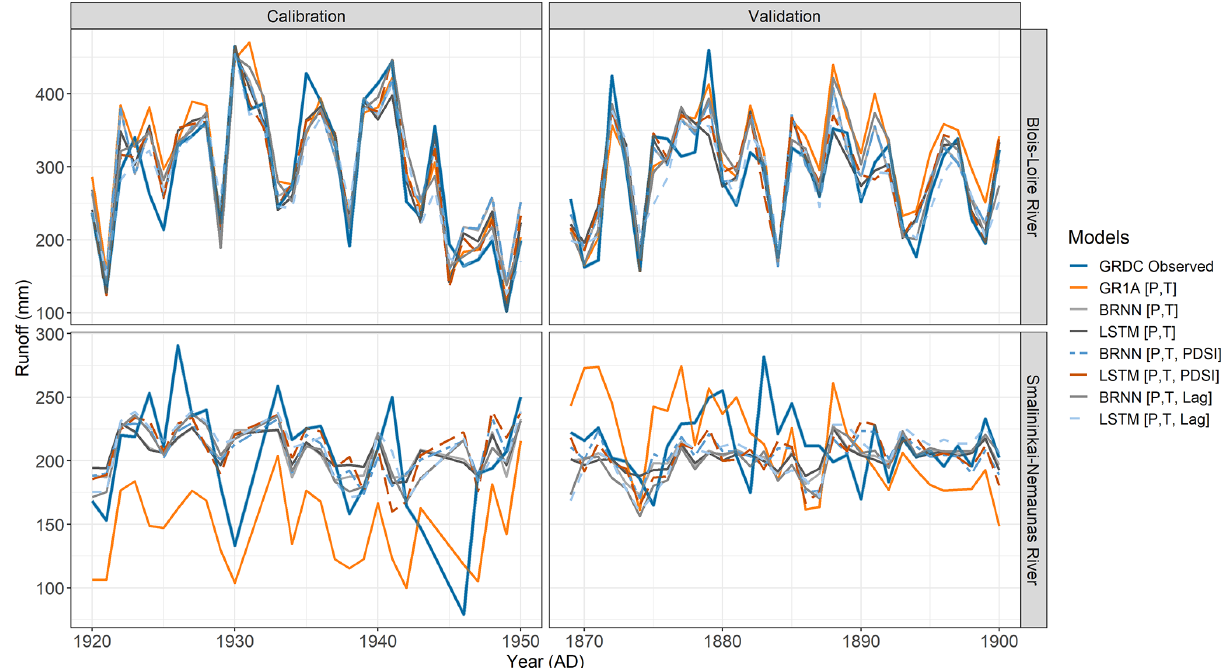
Figure 6. Comparison between the models for the station with the best (Blois–Loire River, top) and the worst (Smalininkai–Nemunas River, bottom) model fit.